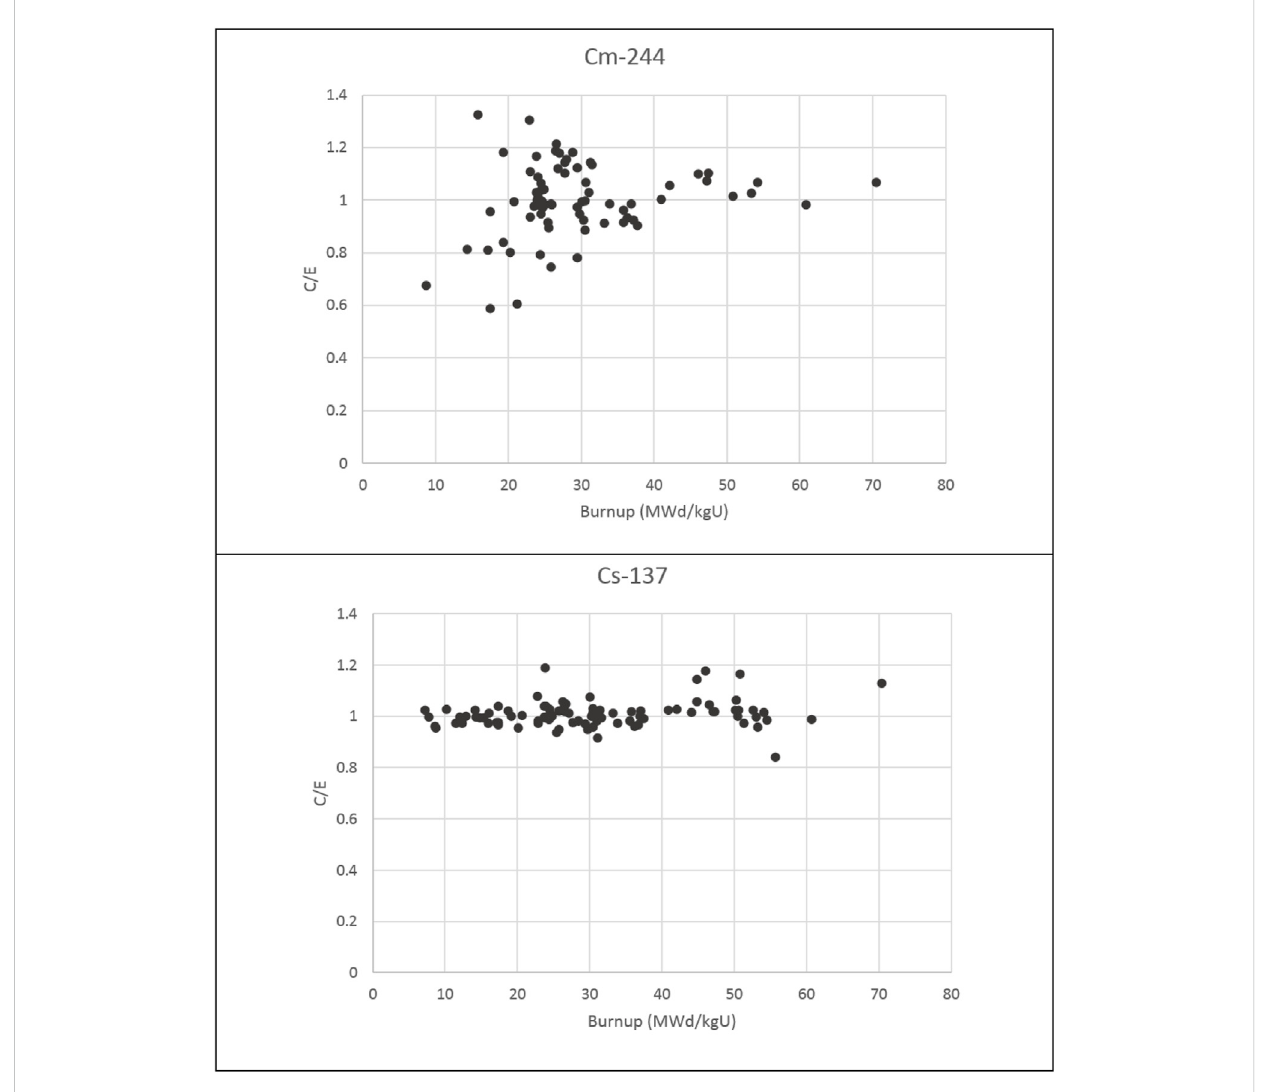
FIGURE 7 C/E values for 244 Cm and 137 Cs from (Radulescu et al.,